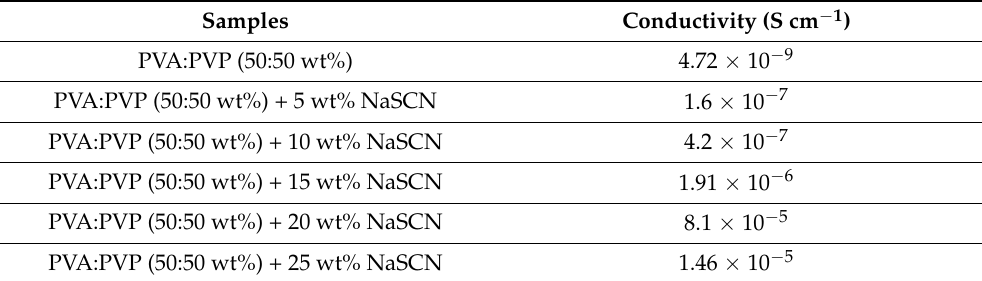
Table 1. Calculated conductivity values of blend PEs at room temperature.